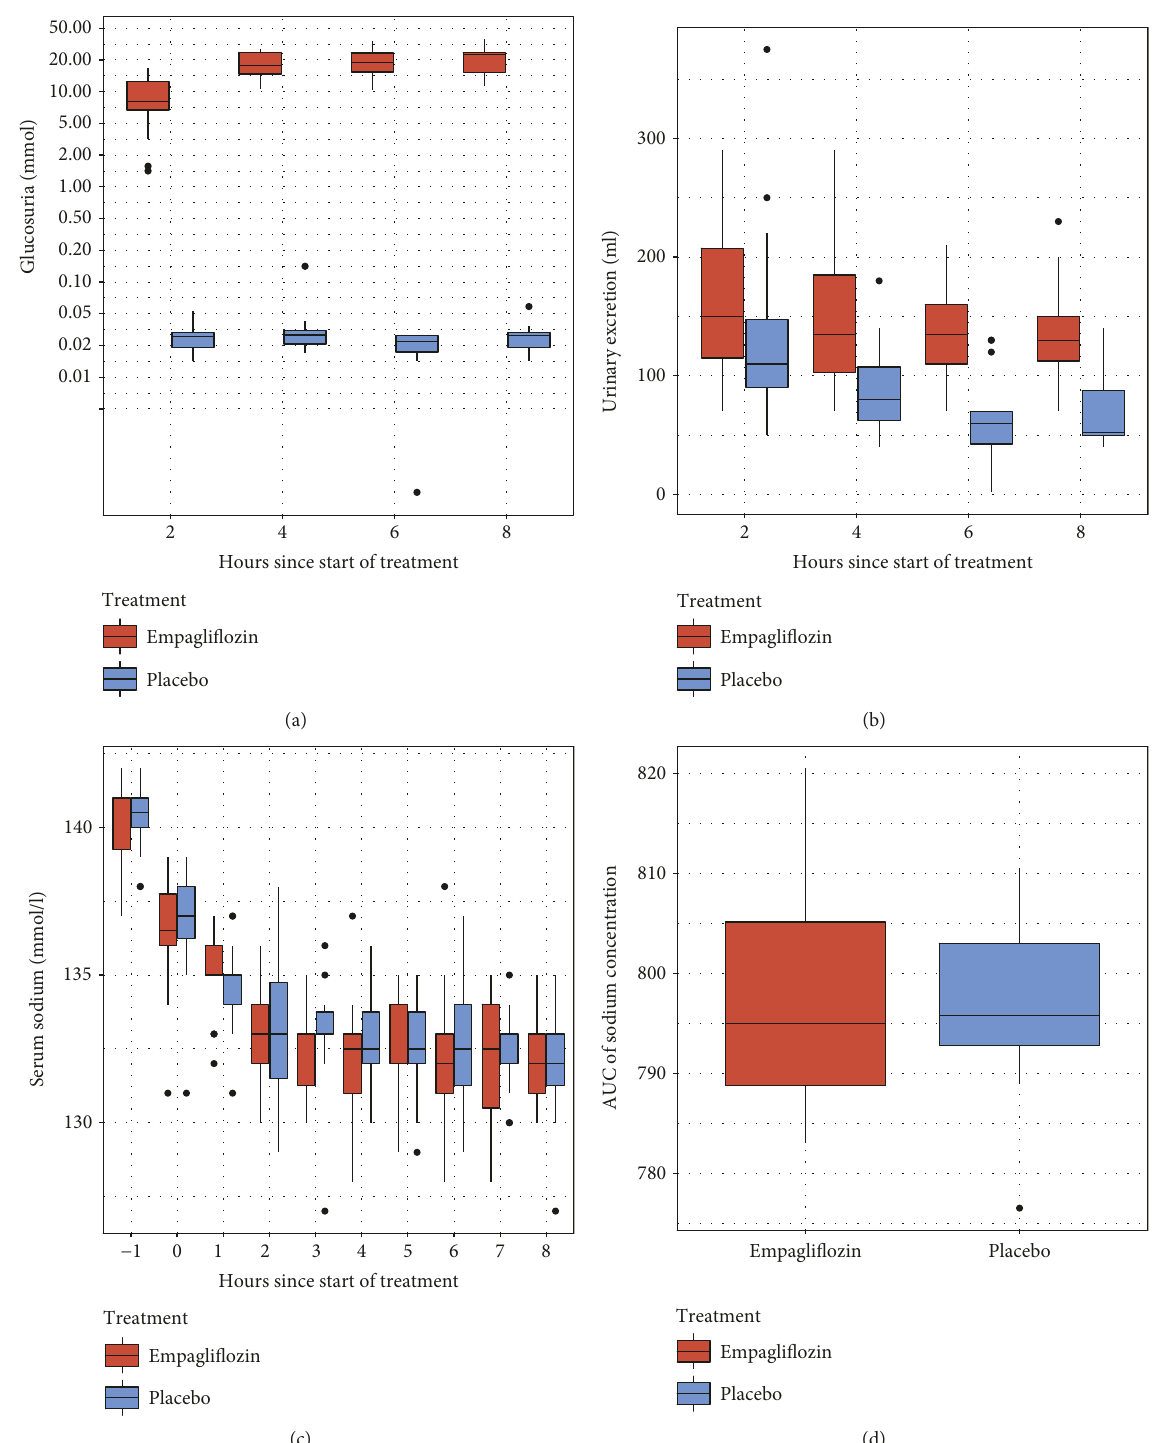
Figure 2: E ffi cacy outcomes according to treatment (empagli fl ozin versus placebo); the thick line indicates the median, the box indicates the interquartile range, and the whiskers include all points within the range of 1.5x the interquartile range. (a) Trajectory of glucosuria (note that y -axis is on log scale). (b) Trajectory of urinary excretion. (c) Trajectory of serum sodium. (d) Area under the curve (timepoints 2 to 8) for serum sodium